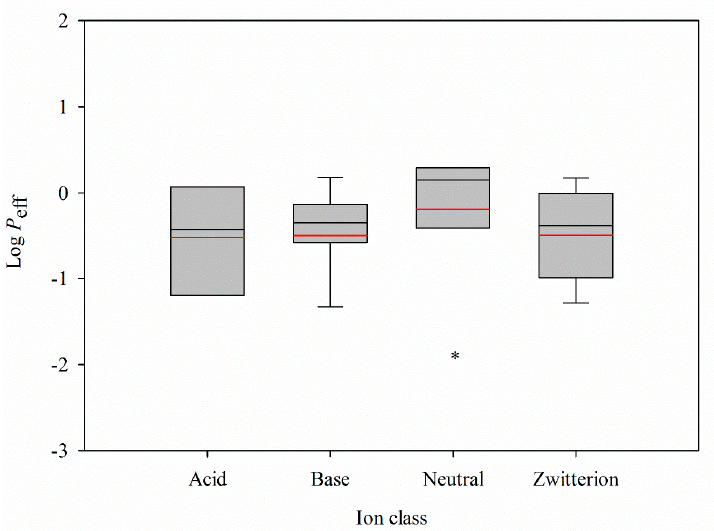
Figure 12. Box plot of log P eff values for different ion classes, where the boxes indicate the distribution of log P eff from the 25th to the 75th percentile, the black and red lines represent the median and mean values, the whiskers depict the minimum and maximum values, and the asterisk denotes significant difference between neutral and the others ( p < 0.05).